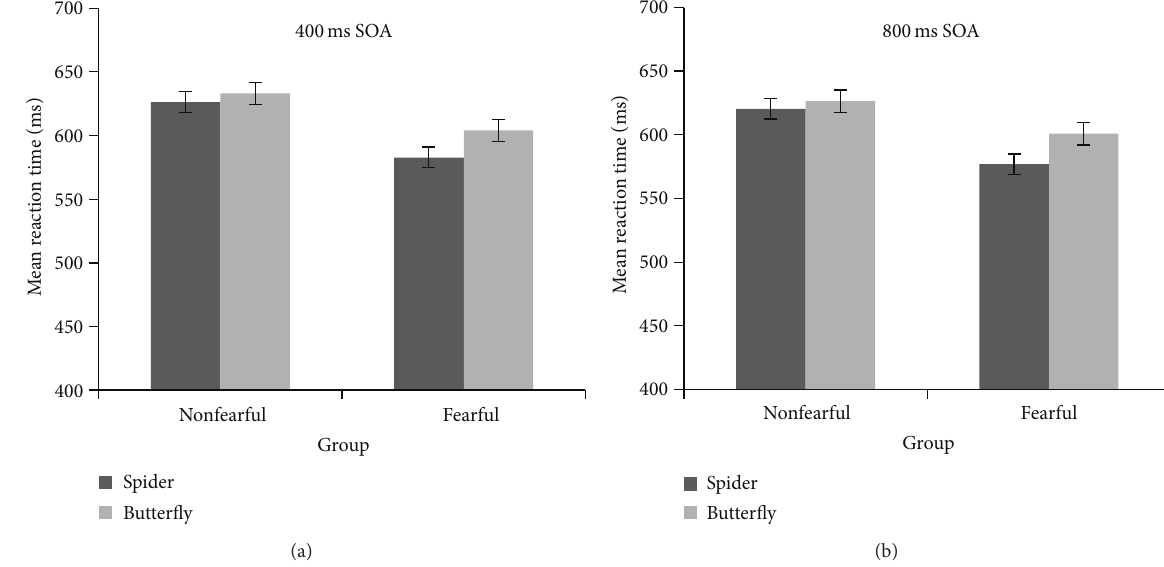
Figure 4: Mean reaction time in milliseconds for the control group and spider fearful group for the 400 ms SOA (a) separately for spider and butterfly targets and for the 800 ms SOA (b). Bars represent the standard error of the